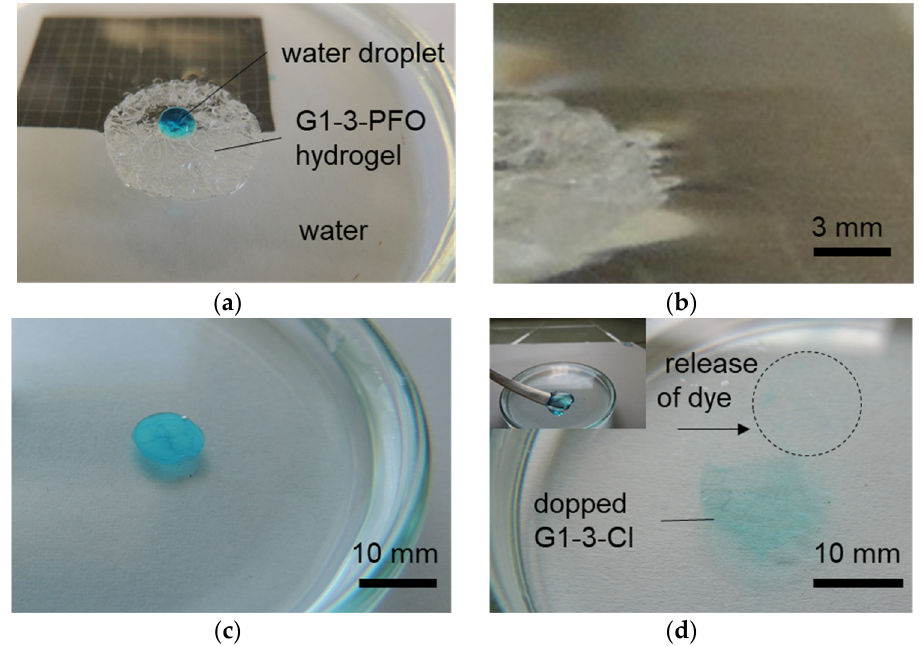
Figure 6. ( a ) Image of a water droplet (doped by methylene blue dye) on top of the G1-3-PFO hy- drogel and floating in a water pool in a Petri dish; ( b ) image indicating the convex meniscus on top of the water, after the immersion of the G1-3-PFO hydrogel in the pool; ( c ) image of the G1-3-PFO hydrogel (doped with methylene blue dye) floating in the water pool in the Petri dish; and ( d ) image of the G1-3-Cl hydrogel (doped with methylene blue dye) sunk under water, with the inlet showing the dopped G1-3-Cl hydrogel before immersion.